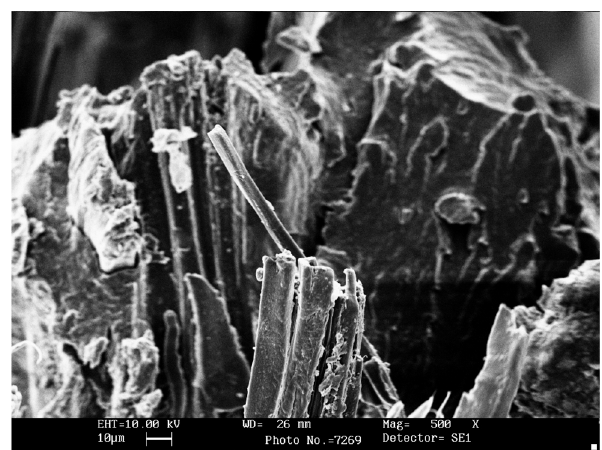
Figure 16: SEM for (15% jute fiber by weight) composite material with coating at 500×.